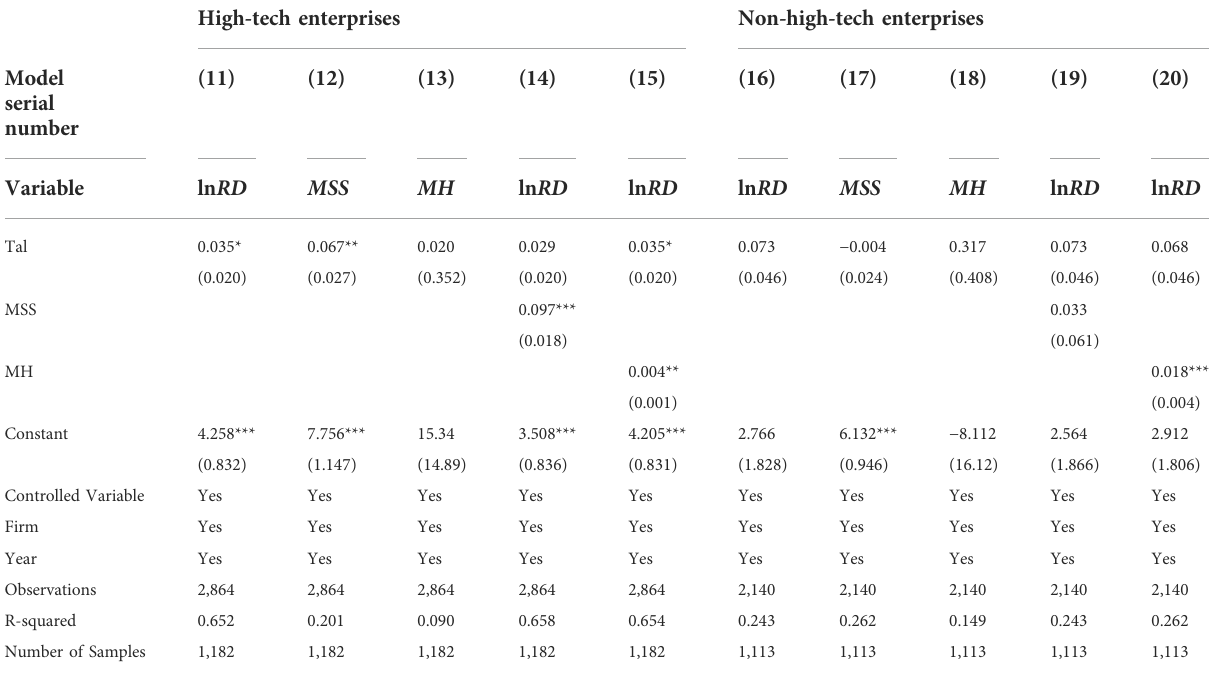
TABLE 6 Sub-sample Regression of whether it is a high-tech